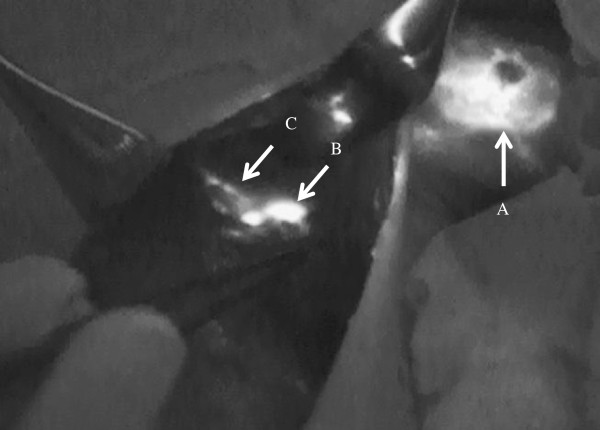
Fluorescence imaging using the Photo Dynamic Eye System. (A, B, C) White arrows indicate the site injected with indocyanine green, ARM lymph nodes, and ARM lymphatic ducts, respectively.